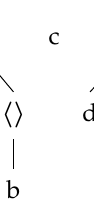
ε ε seen as a a b c d (cid:104) (cid:105) · (cid:105) · (cid:105)(cid:105) · (cid:104) · (cid:104) · (cid:104)